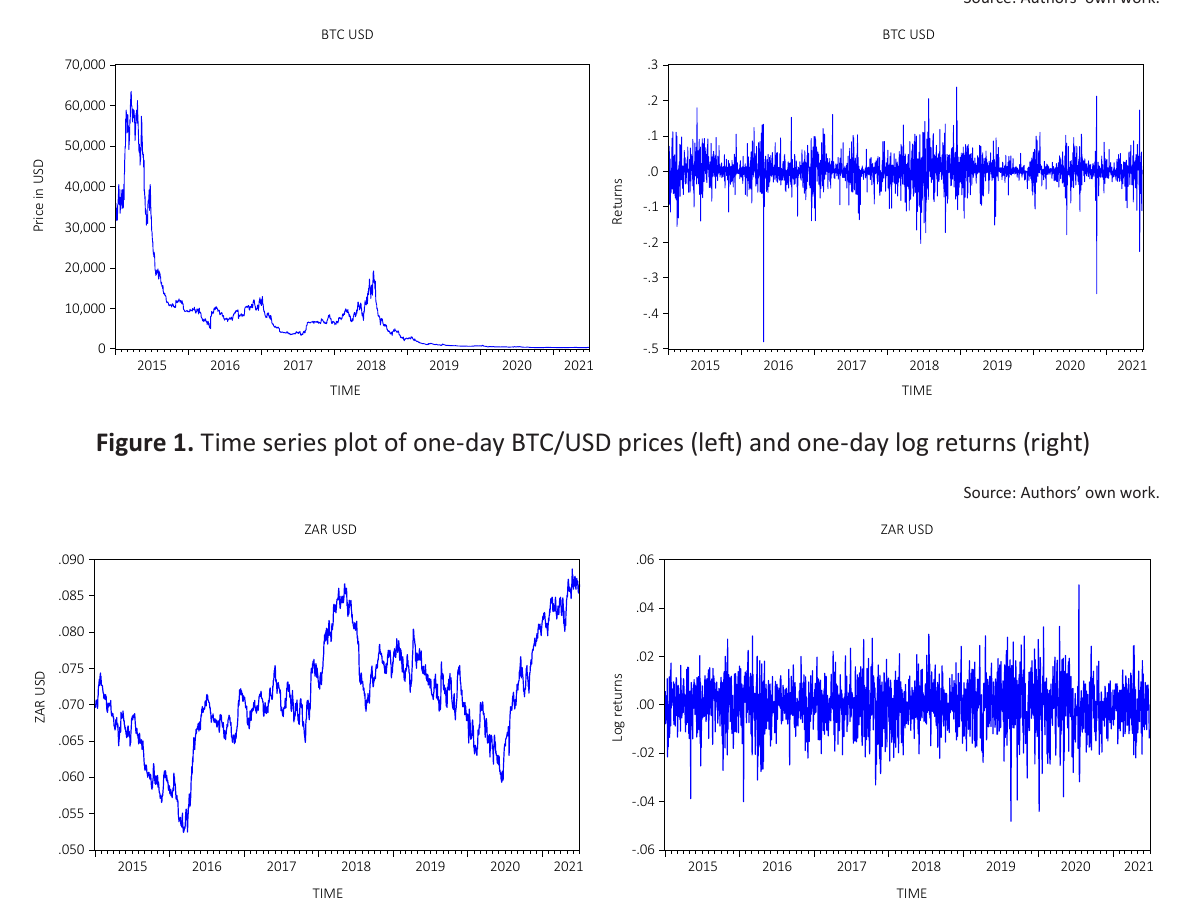
Figure 2. Time series plot of ZAR/USD prices (left) and one-day log returns (right)